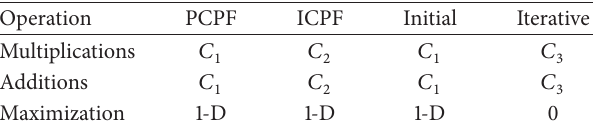
Table 1: Comparison of the computational